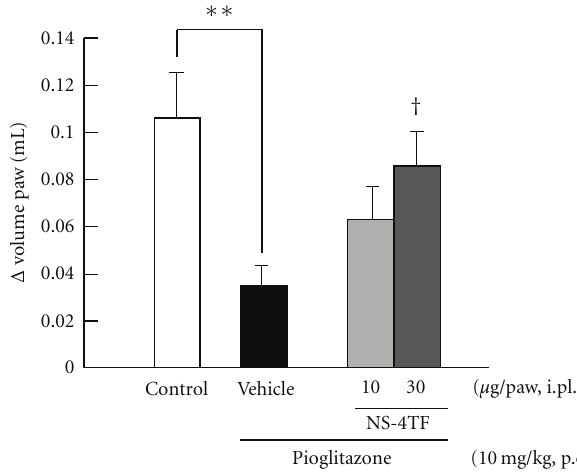
Figure 2: Influence of RXR antagonists on PPAR γ agonist-induced anti-inflammatory e ff ects . Pioglitazone was orally administrated 3 h before carrageenan injection at a dose of 10mg/kg. RXR antagonist, NS-4TF was injected into subplantar 15min before carrageenan injection at doses of 10 and 30 μ g/paw. The vehicle group received physiological saline including 10% dimethylsulphoxide. Each col- umn and vertical bar represents the means ± S.E.M. ( n = 7). ∗∗ : Significantly di ff erent from the control group at P < 0 . 01 (Dunnett’s test). † : Significantly di ff erent from the vehicle group at P < 0 . 05 (Dunnett’s